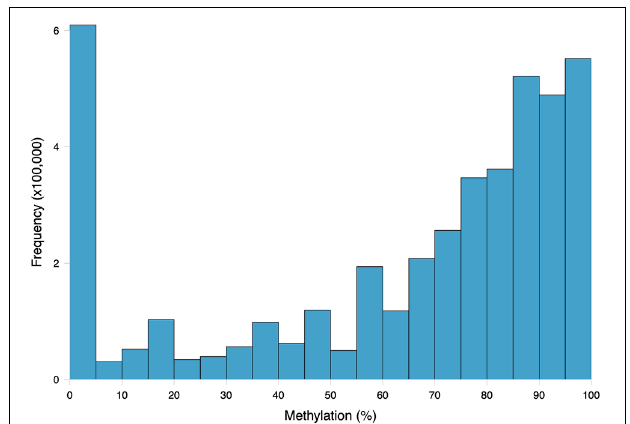
FIGURE 1 | Frequency distribution of methylation ratios for CpG loci in C. virginica gonad tissue DNA subjected to MBD enrichment. A total of 4,304,257 CpGs with at least 5 × coverage summed across all ten samples were characterized. Loci were considered methylated if they were at least 50% methylated, sparsely methylated loci were 10–50% methylated, and unmethylated loci were 0–10% methylated.